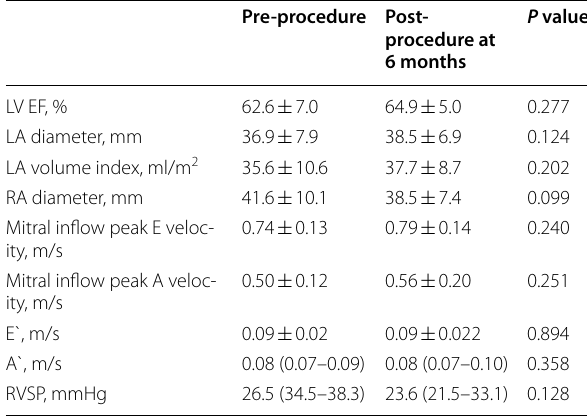
LV Left ventricle; EF Ejection fraction; LA Left atrium; RA Right atrium; RVSP Right ventricular systolic